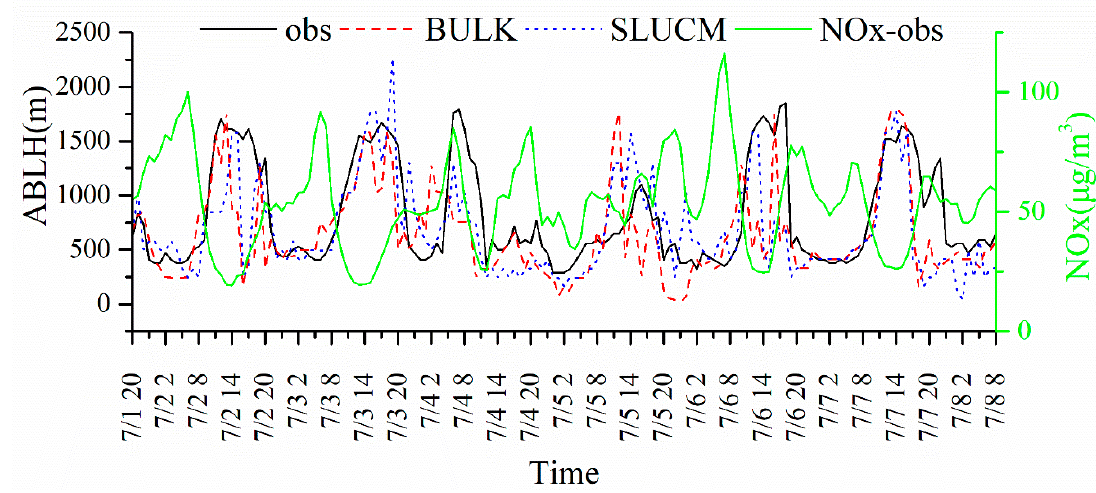
Figure 6. Observed and simulated ABL height (ABLH) at station s2 and average NOx concentrations in Shanghai on 1–8 July 2011.